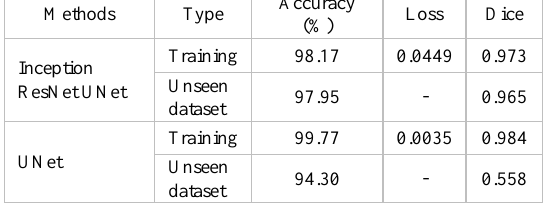
Table 1. Result of training for both network architectures